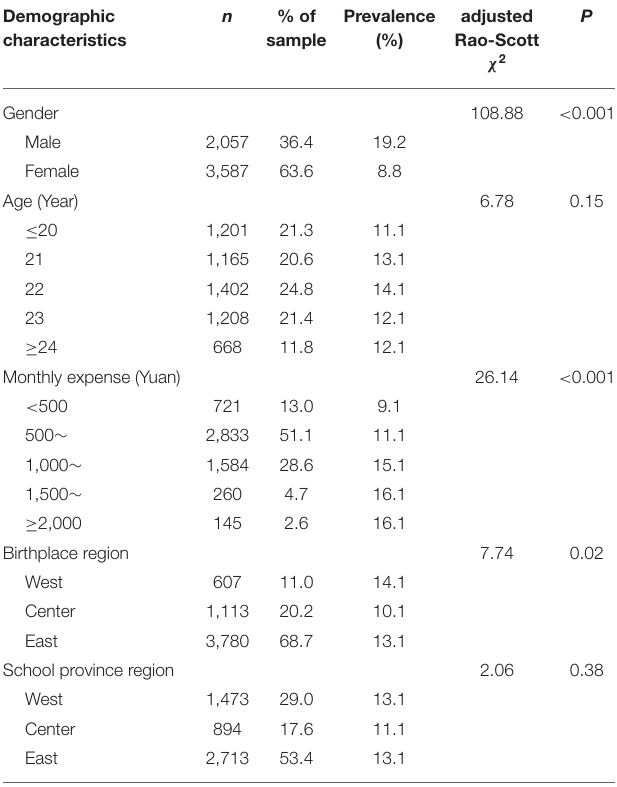
TABLE 1 | Descriptive statistics and Chi-square test for IA prevalence of different sociodemographic characteristics ( N = 5,644). Demographic